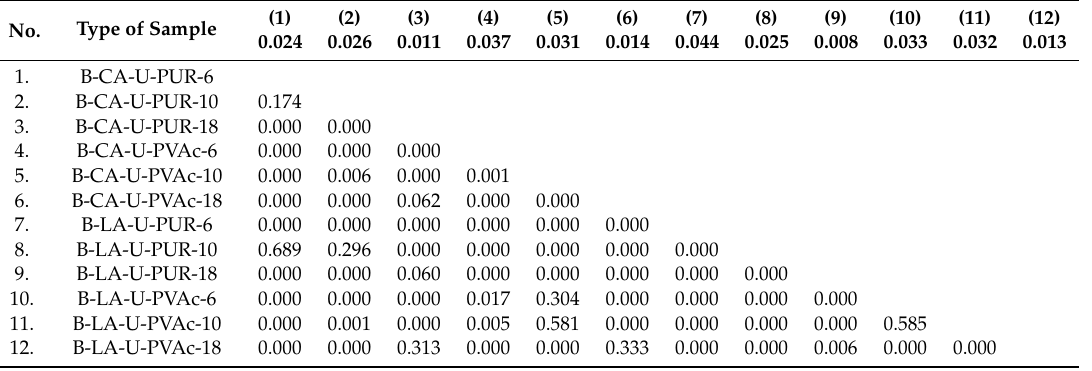
Table 22. Comparison of the e ff ects of individual factors using Duncan’s test on the coe ffi cient of bendability ( K bendC ) for beech and NWC on